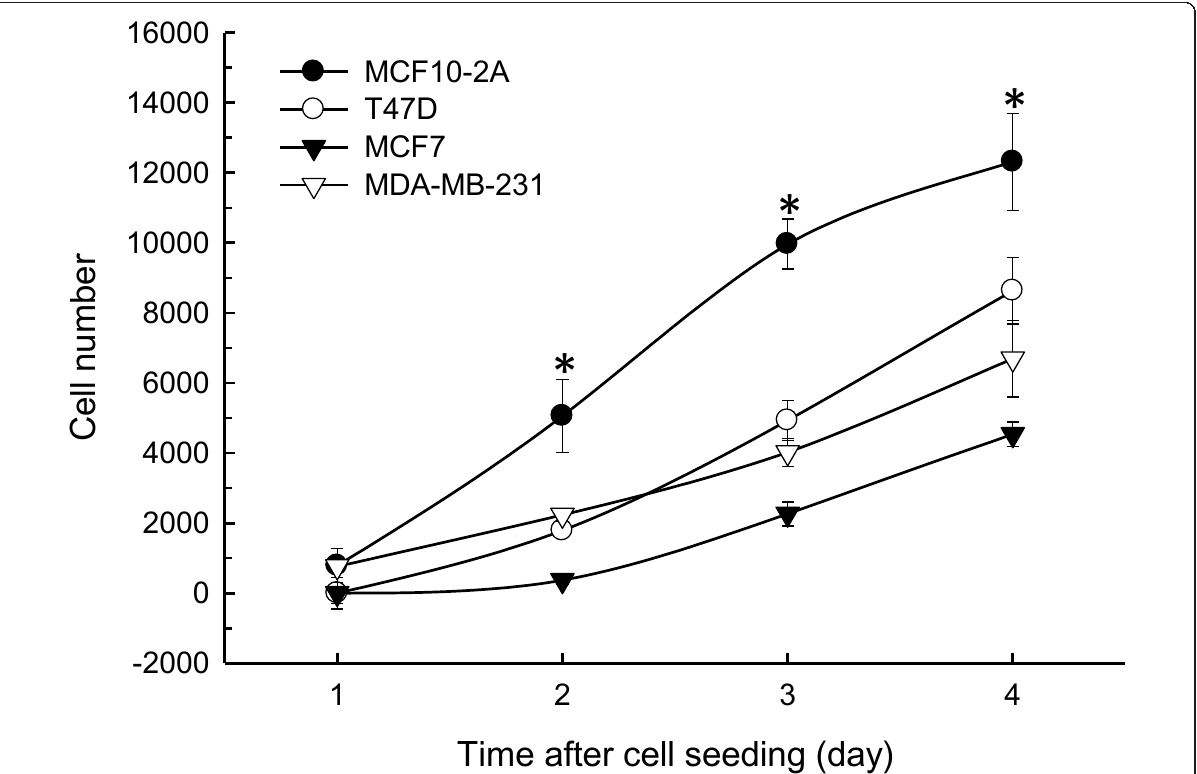
Figure 1 Human breast cell growth . Human breast cancer cells and immortalized normal breast epithelial cells (1x10 3 ) were seeded in triplicate in their culture media, and quantified for their growth between 1 and 4 days following cell seeding. Cell numbers were calculated from standard curves with known numbers of cells. Results are presented as mean ± SEM from 4 independent experiments. * indicates statistical differences between normal and malignant cells at P < 0.05.